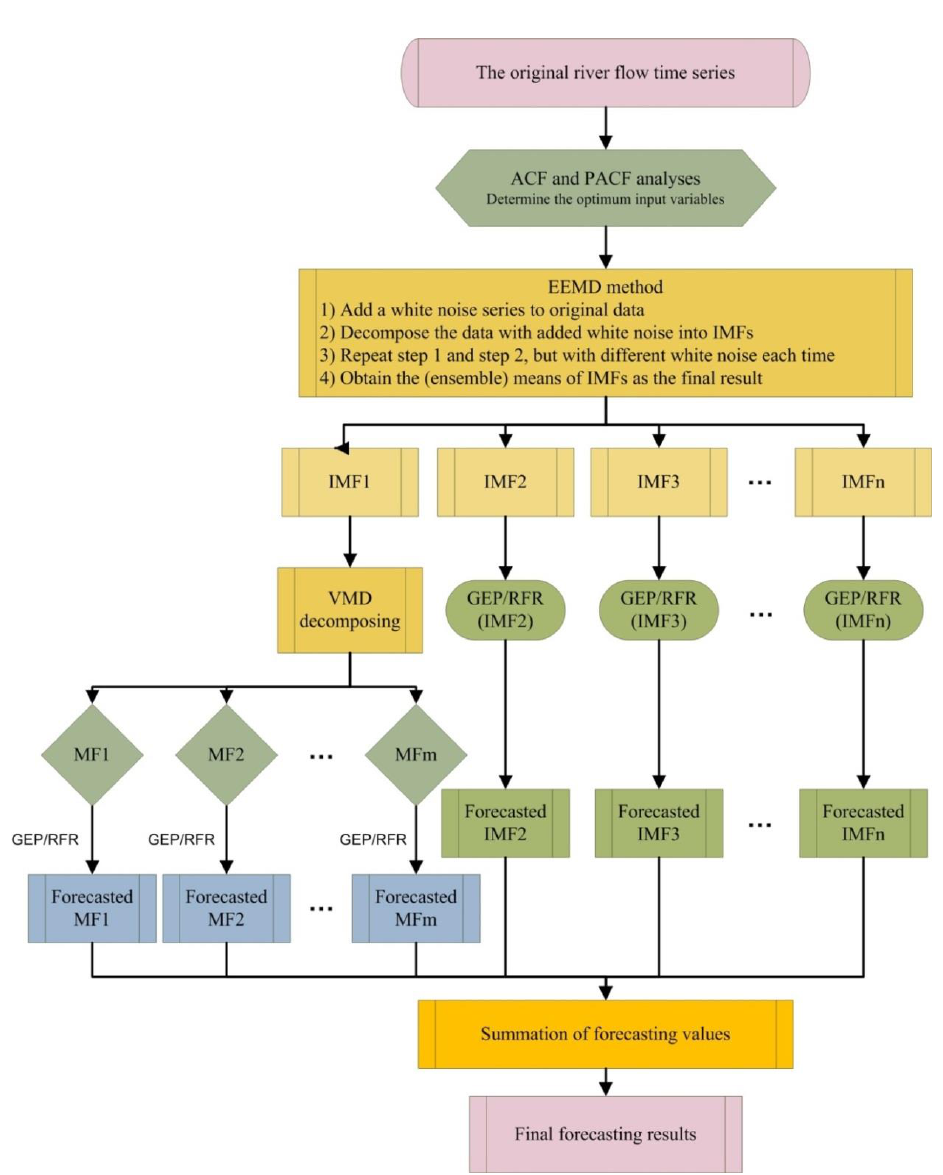
Figure 6. A flow chart of the ensemble GEP and RFR integrated with the EEMD and VMD approaches.